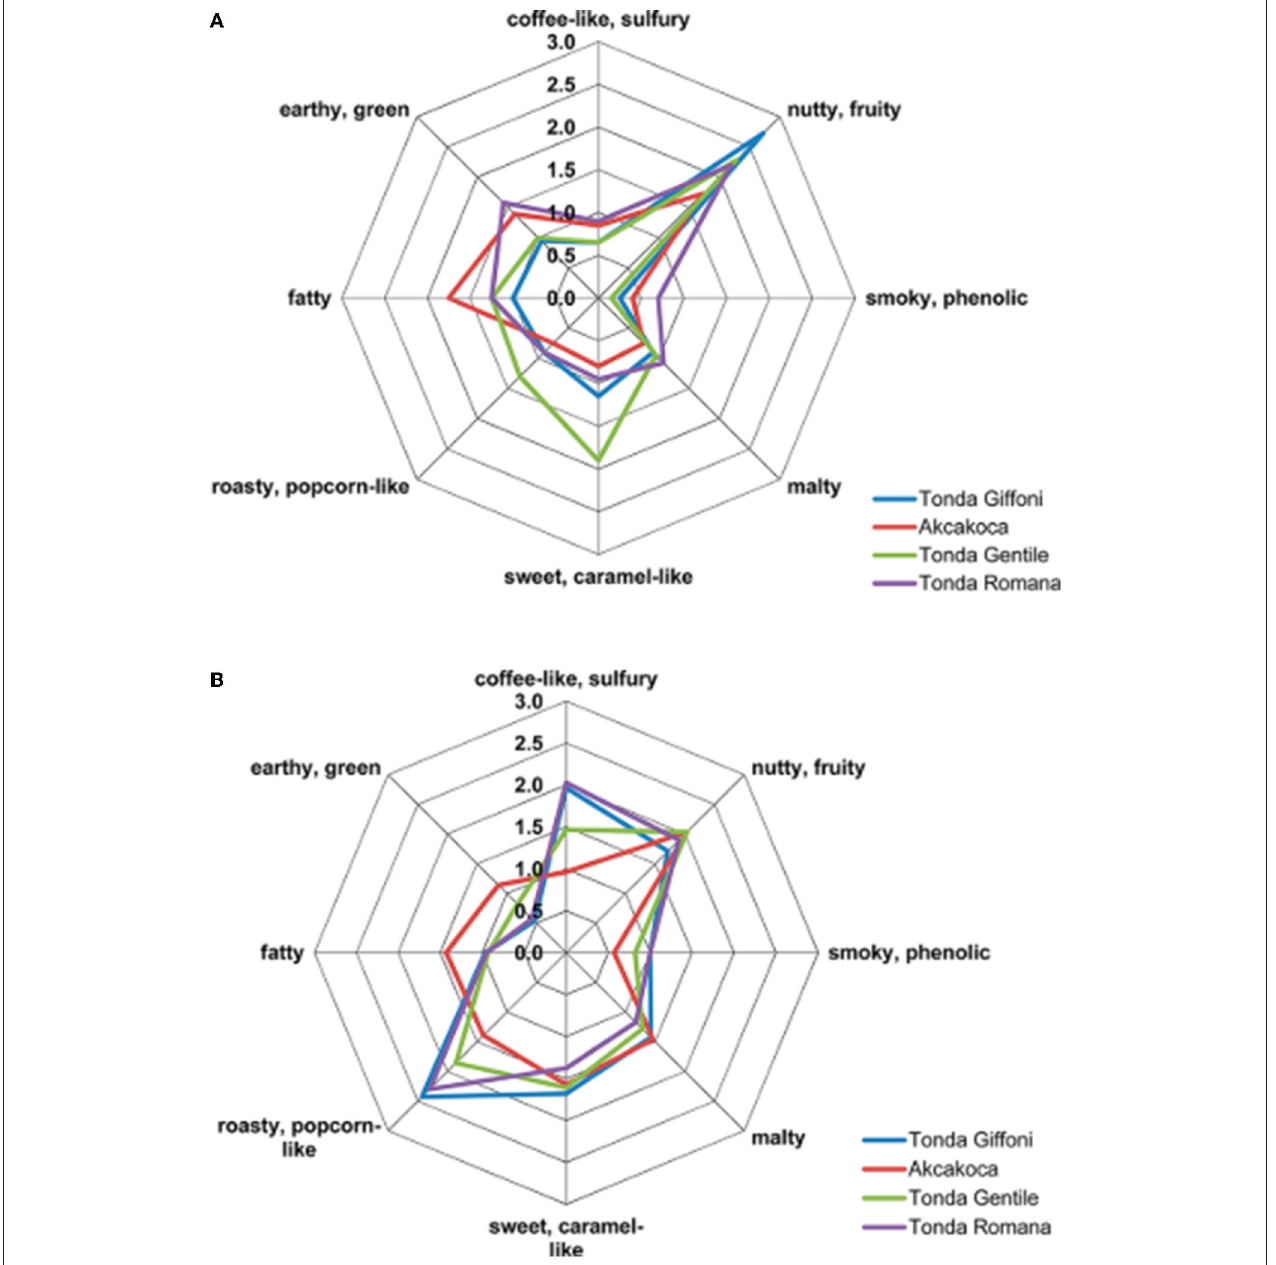
FIGURE 3 | Qualitative sensory analysis results illustrated as spider graphs and corresponding to four hazelnuts cultivars/blends as raw (A) and roasted (B) [23min at 160 ◦ C] kernels. Figure from Kiefl and Schieberle (2013).